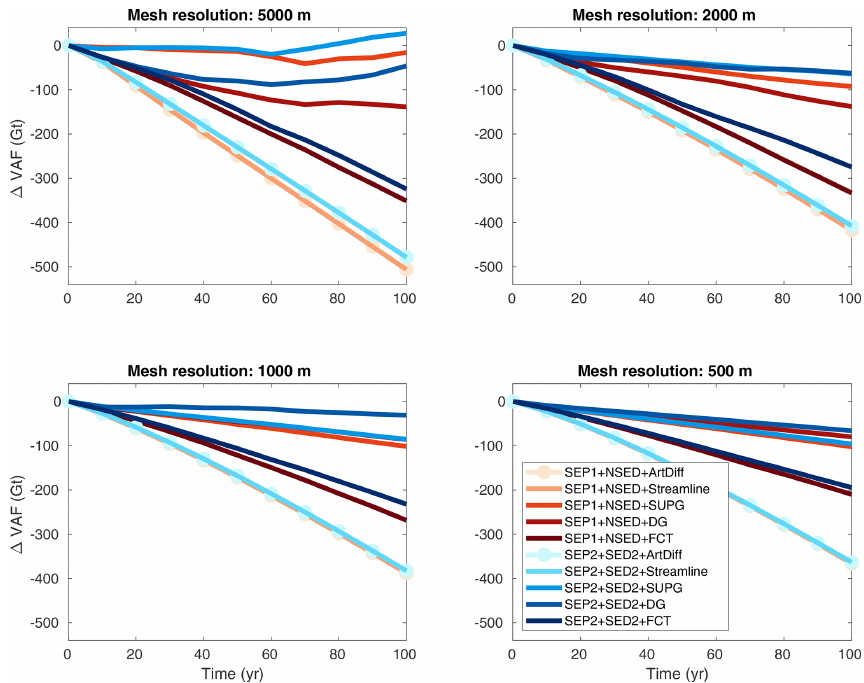
Figure 7. Basal melt experiment (no melt on partly floating elements): evolution of (cid:49) VAF for different mesh resolutions and stabilization schemes (see legend). Two sets of sub-element parameterizations are employed: SEP1 + NSED and SEP2 + SED2.